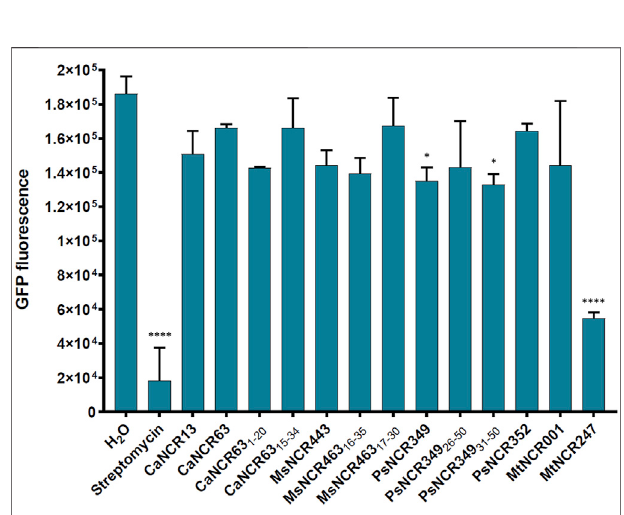
FIGURE 5 | GFP production by E. coli in vitro coupled transcription- translation assay in the presence of 100 µM NCR or streptomycin. GFP fl uorescence represents the average values of 2 technical parallels with their respective standard deviations (SD). *: p < 0.05, ****: p < 0.0001, as determined by one-way